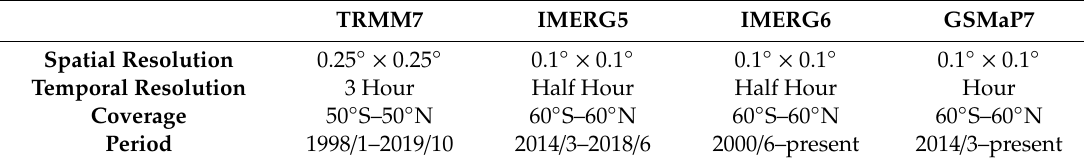
Table 1. Information about the satellite precipitation products (SPPs) used in this